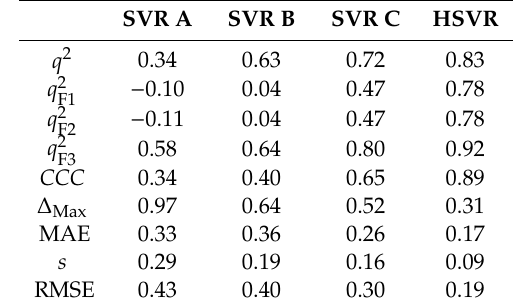
Table 4. Statistic evaluations, correlation coefficients q 2 , q 2